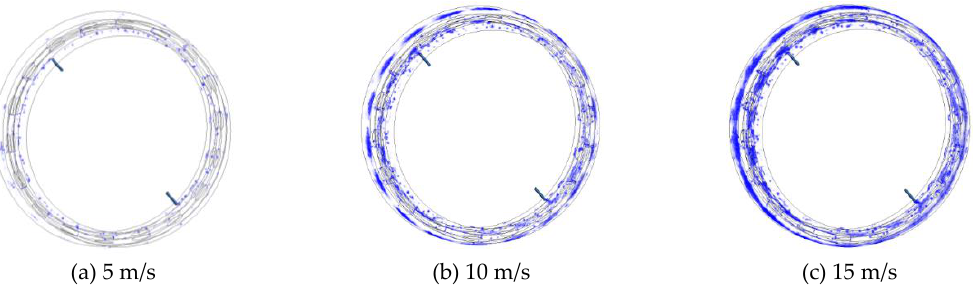
Figure 7. Oil distribution inside the ball bearing with different oil inlet velocities.